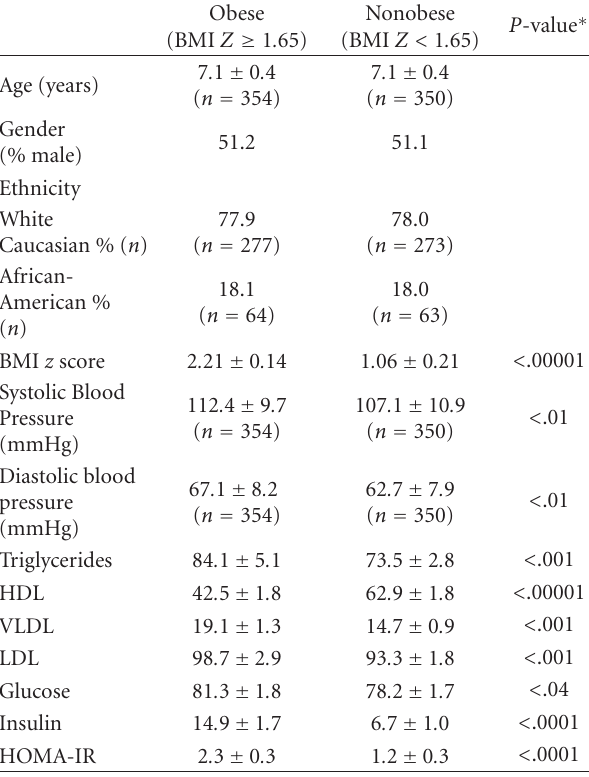
Table 2: Fasting morning plasma concentrations of inflammatory biomarkers in obese and nonobese